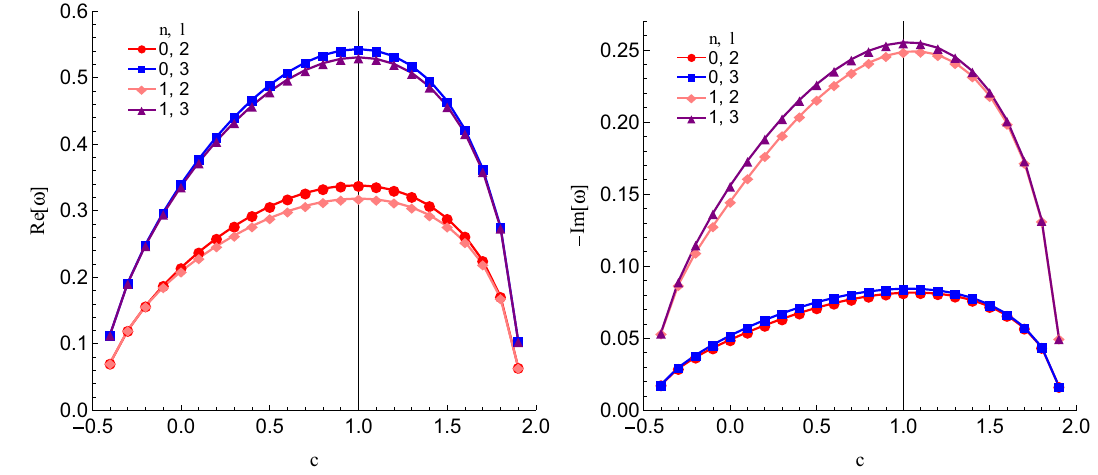
Fig. 3 Re [ ω ] and Im [ ω ] as a function of c for (cid:12) = 0 . 02 and unit mass calculated by using the sixth order WKB formula. The vertical line indicates the frequencies of the Schwarzschild-dS black hole. Both the real and imaginary parts of QN frequencies decrease whenever c deviates from